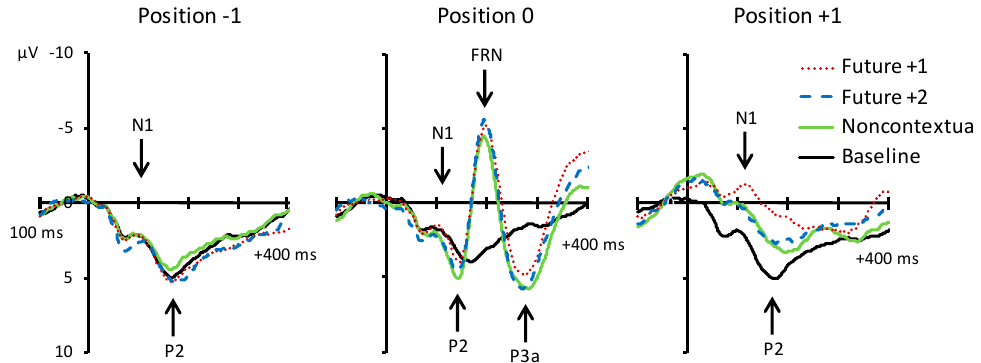
Figure 4. Grand average event-related potentials (ERPs) elicited by the four experimental conditions relative to target event positions − 1, 0, and +1. Activity shown is averaged across all electrodes contained within the anterior region of interest (ROI). Negative is plotted upward.